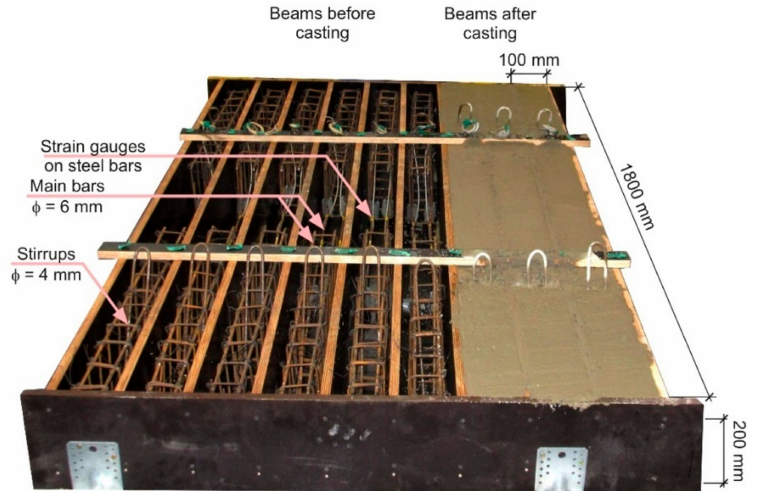
Figure 5. View of the RC beams before and after casting. The beams with an overall length of 1.8 m were subjected to the four-point bending tests (Figure 6). The span of the beam was equal to l = 1.6 m. The load was applied with the constant rate of displacement equal to 1 mm/min till the failure of the specimen.